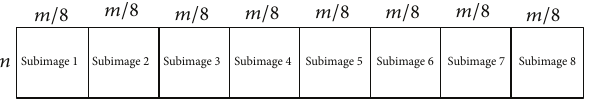
Figure 3: Splitting an image to 8